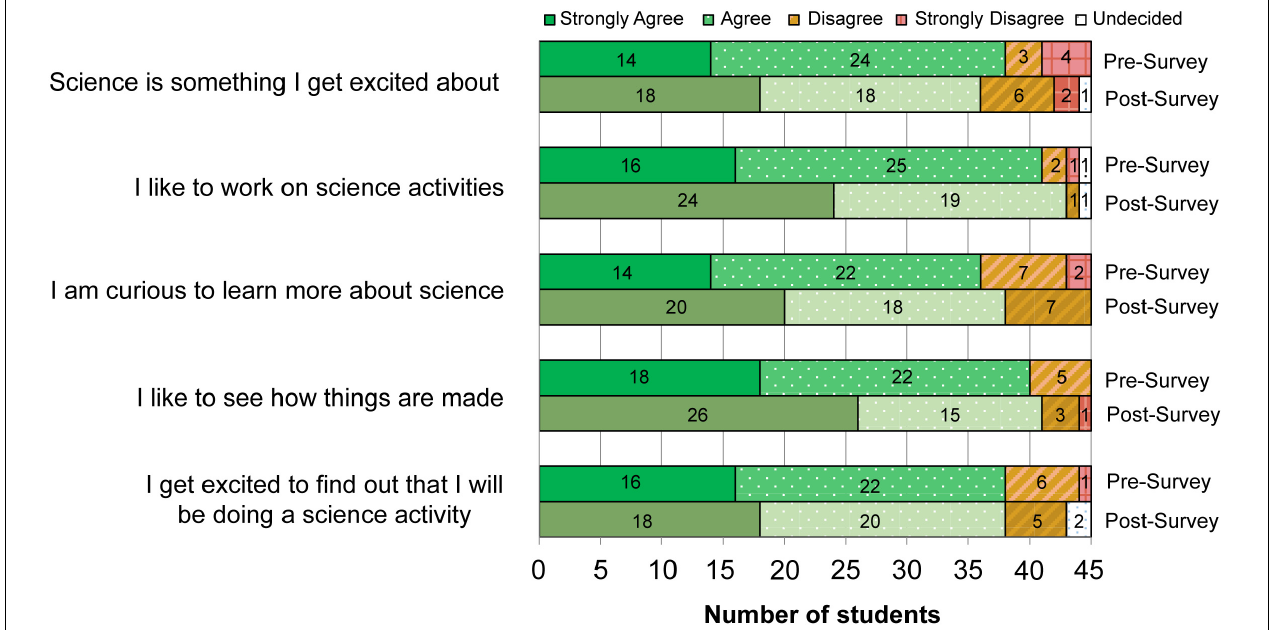
FIGURE 5 | Noyce enthusiasm for science statements. Results from the questions that evaluate enthusiasm toward science learning. Demonstrates the number of students that selected each answer. Pre and post survey answers are stacked directly, respectively, on top of each other for each question. Cronbach alpha 0.831 and 0.827 for pre and post survey, respectively.